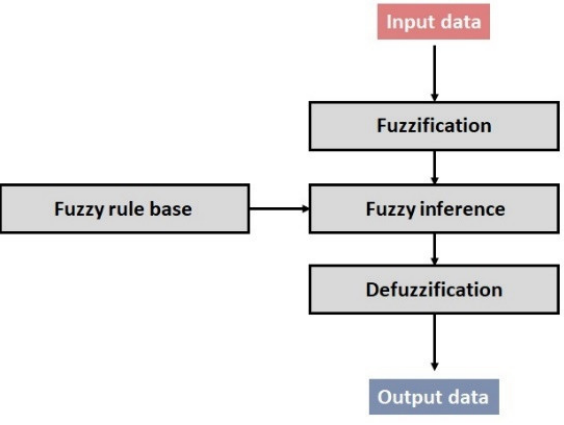
Figure 2. Fuzzy logic system [54].